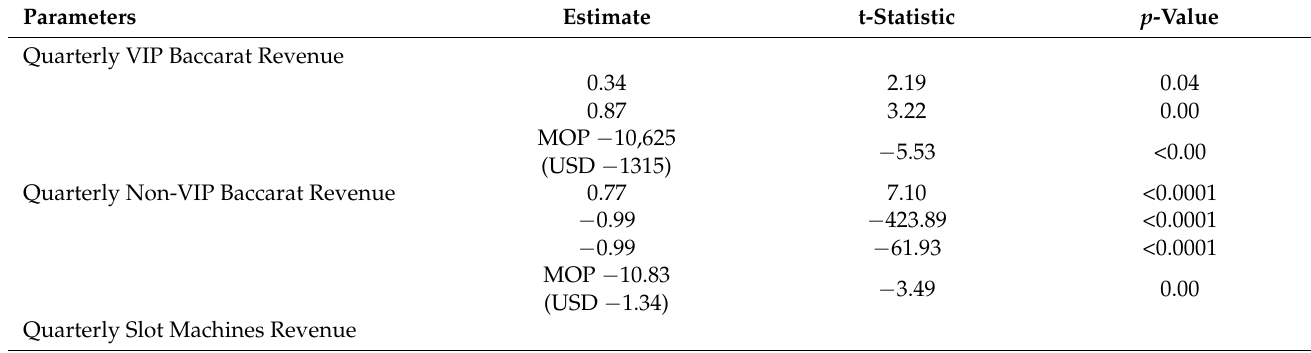
Table 3. Impact Identified (in